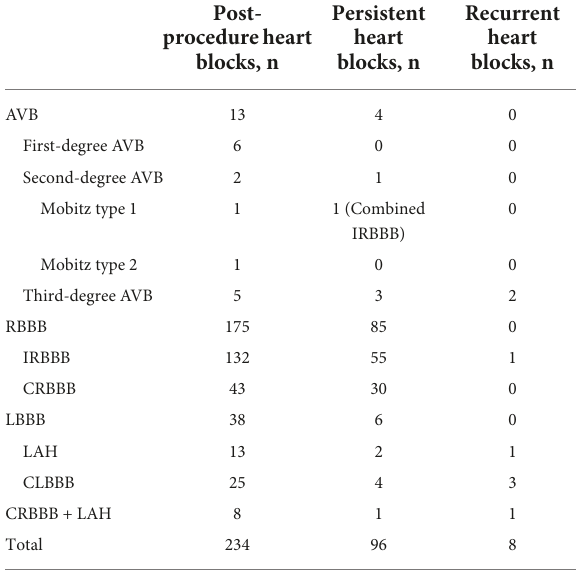
TABLE 1 General characteristics. TABLE 2 Post-procedural, persistent, and recurrent heart blocks.